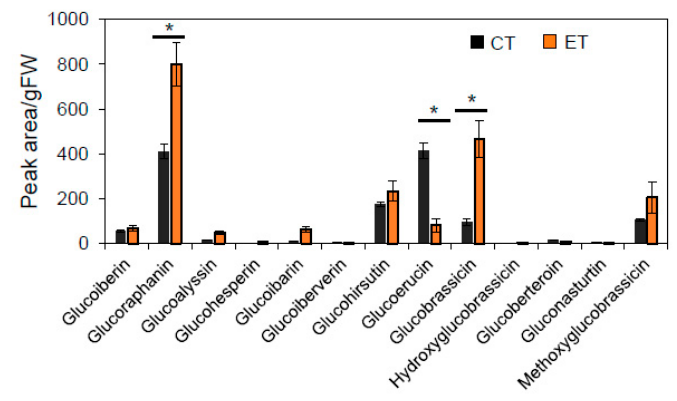
Figure 3. Elevated temperature alters the pattern of glucosinolate accumulation in Arabidopsis leaves. Plants were grown continuously at CT for four weeks prior to a 7-day acclimation period at either CT (black bars) or ET (orange bars), after which time leaves were sampled for measurement of glucosinolate content by LC-MS. The data show the abundance of glucosinolate species per gram fresh weight (g FW) leaf tissue obtained from three biological replicates. The asterisks denote significant differences between ET and CT according to Tukey’s HSD test (P < 0.05).